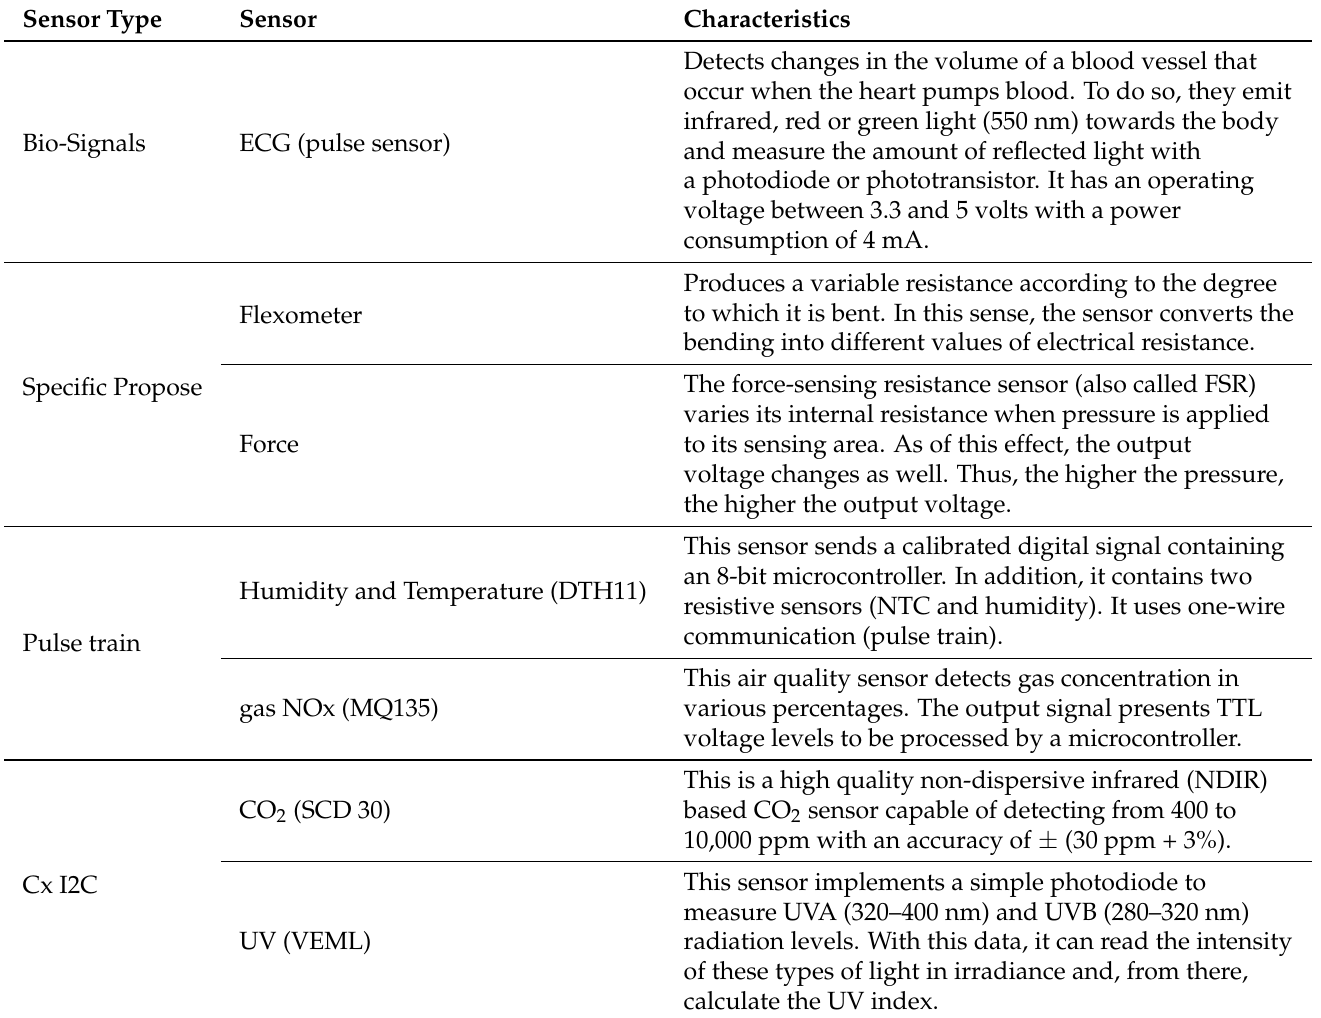
Table 1. Most commonly used sensors in IoT devices regarding the proposed